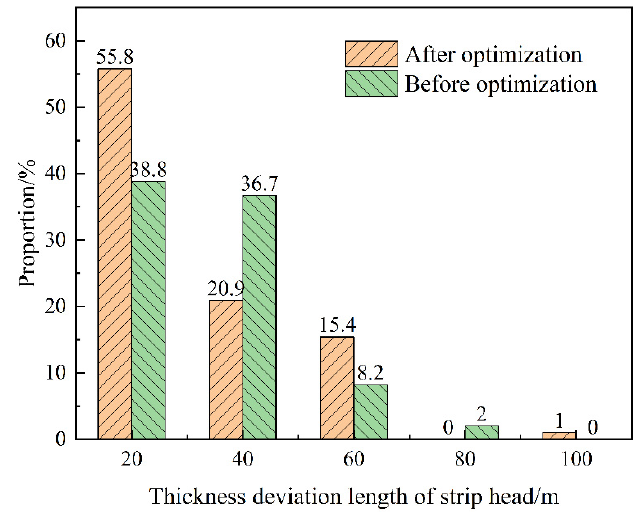
Figure 16. The proportion of thickness defects after